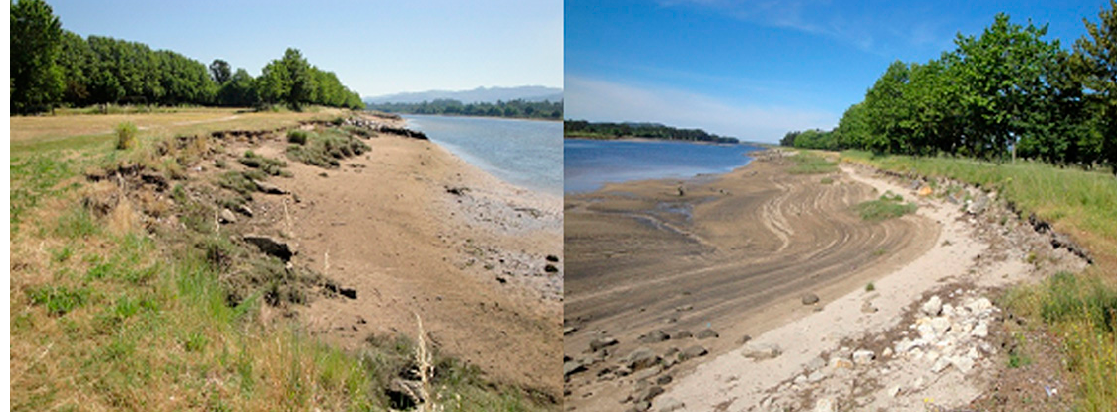
Figure 8. Two segments of the estuary banks, adjacent to the rehabilitation project in Cardielos (2014), showing that the severe erosion still progresses along the un-revetted banks, either in the upper section (left) or in the lower section (right), which requires an extension of the techniques already implemented.